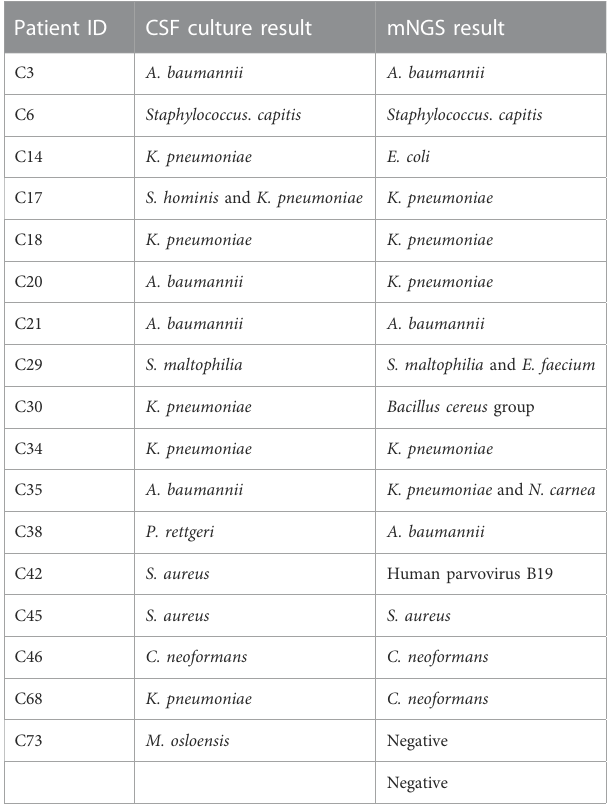
TABLE 2 Samples with positive CSF